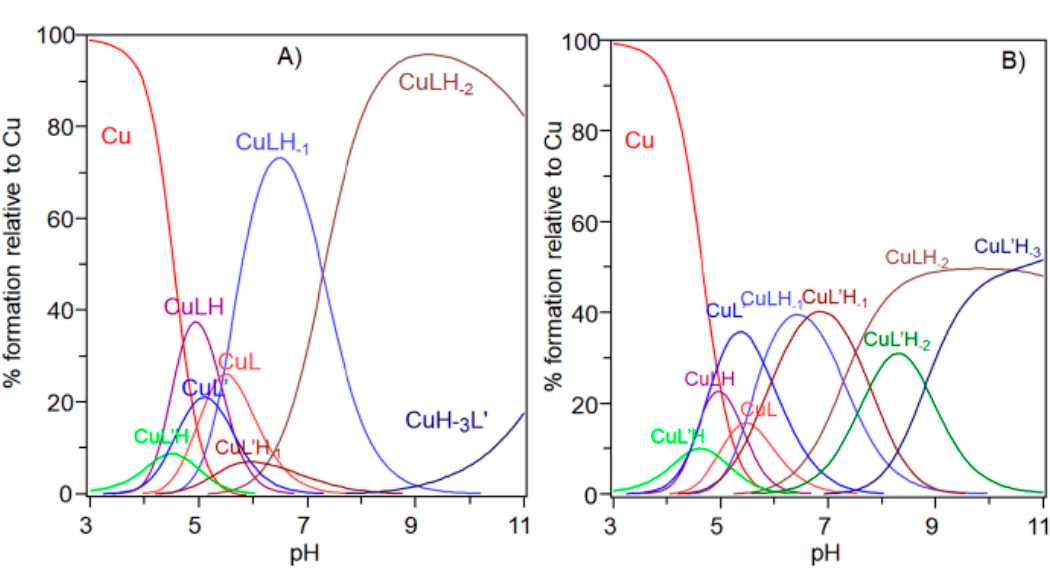
Figure 7. Species distribution diagram for the copper(II) complexes formed with the NGF(1–14) (L) and Ac-SLHHLPG-NH 2 (L’) at ( A ) 1:1:1 Cu,L,L’ molar ratio and ( B ) 1:1:2 Cu,L,L’ ([Cu 2+ ] = 1 × 10 − 3 mol dm − 3